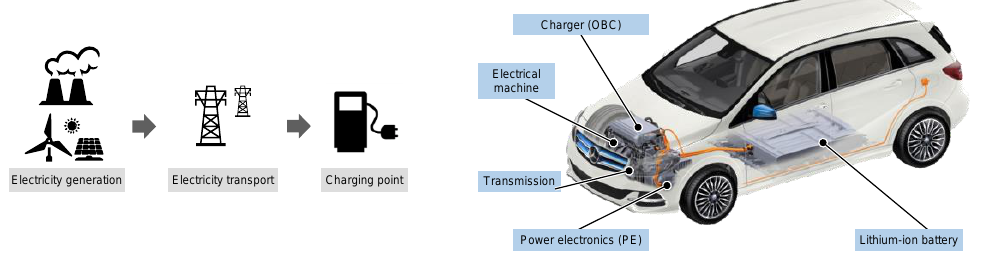
Figure 1. Components of BEV powertrains [6].